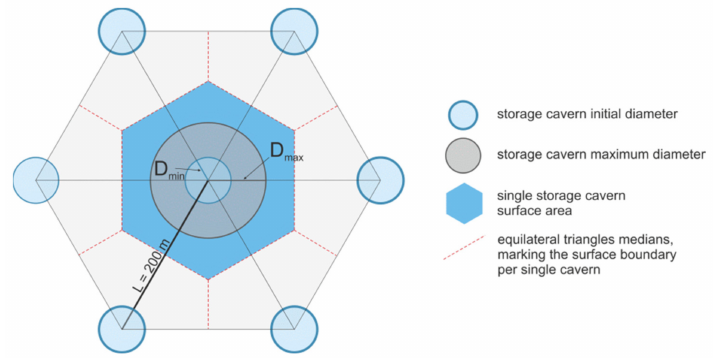
Figure 3. The cavern spacing triangular